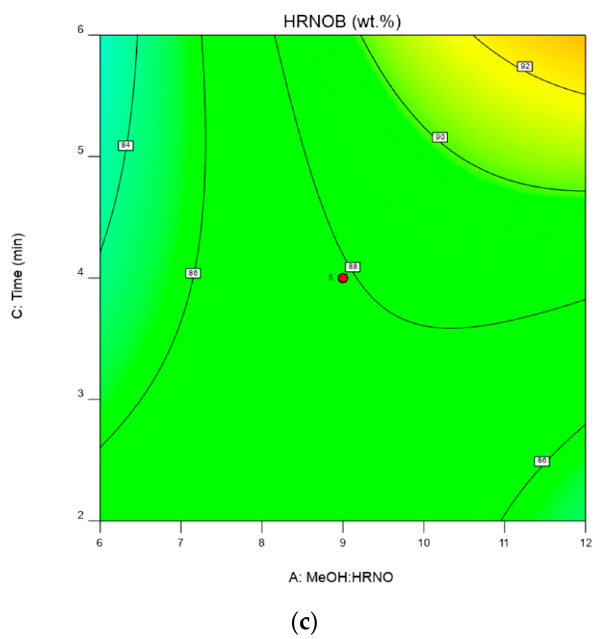
Figure 8. ( a )—Two-dimensional plot of CPK loading and MeOH:HRNO on HRNOB yield. ( b )—Two-dimensional plot of CPK loading and time on HRNOB yield. ( c )—Two-dimensional plot of time and MeOH: HRNO on HRNOB yield.